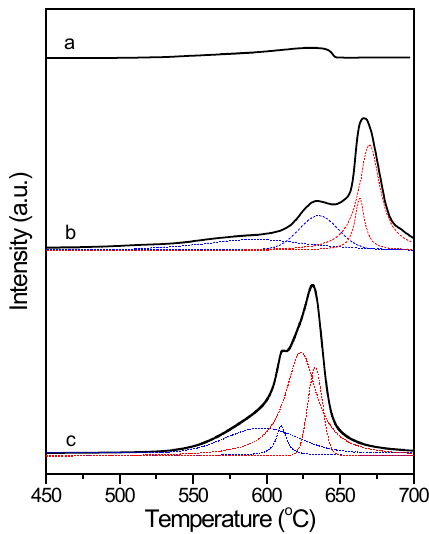
Figure 6. TPR (Temperature Programed Reduction) profiles of: ( a ) CPM; ( b ) APMV; and ( c ) APMV/CPM catalyst (Blue lines: reduction of V species, red lines: reduction of Mo